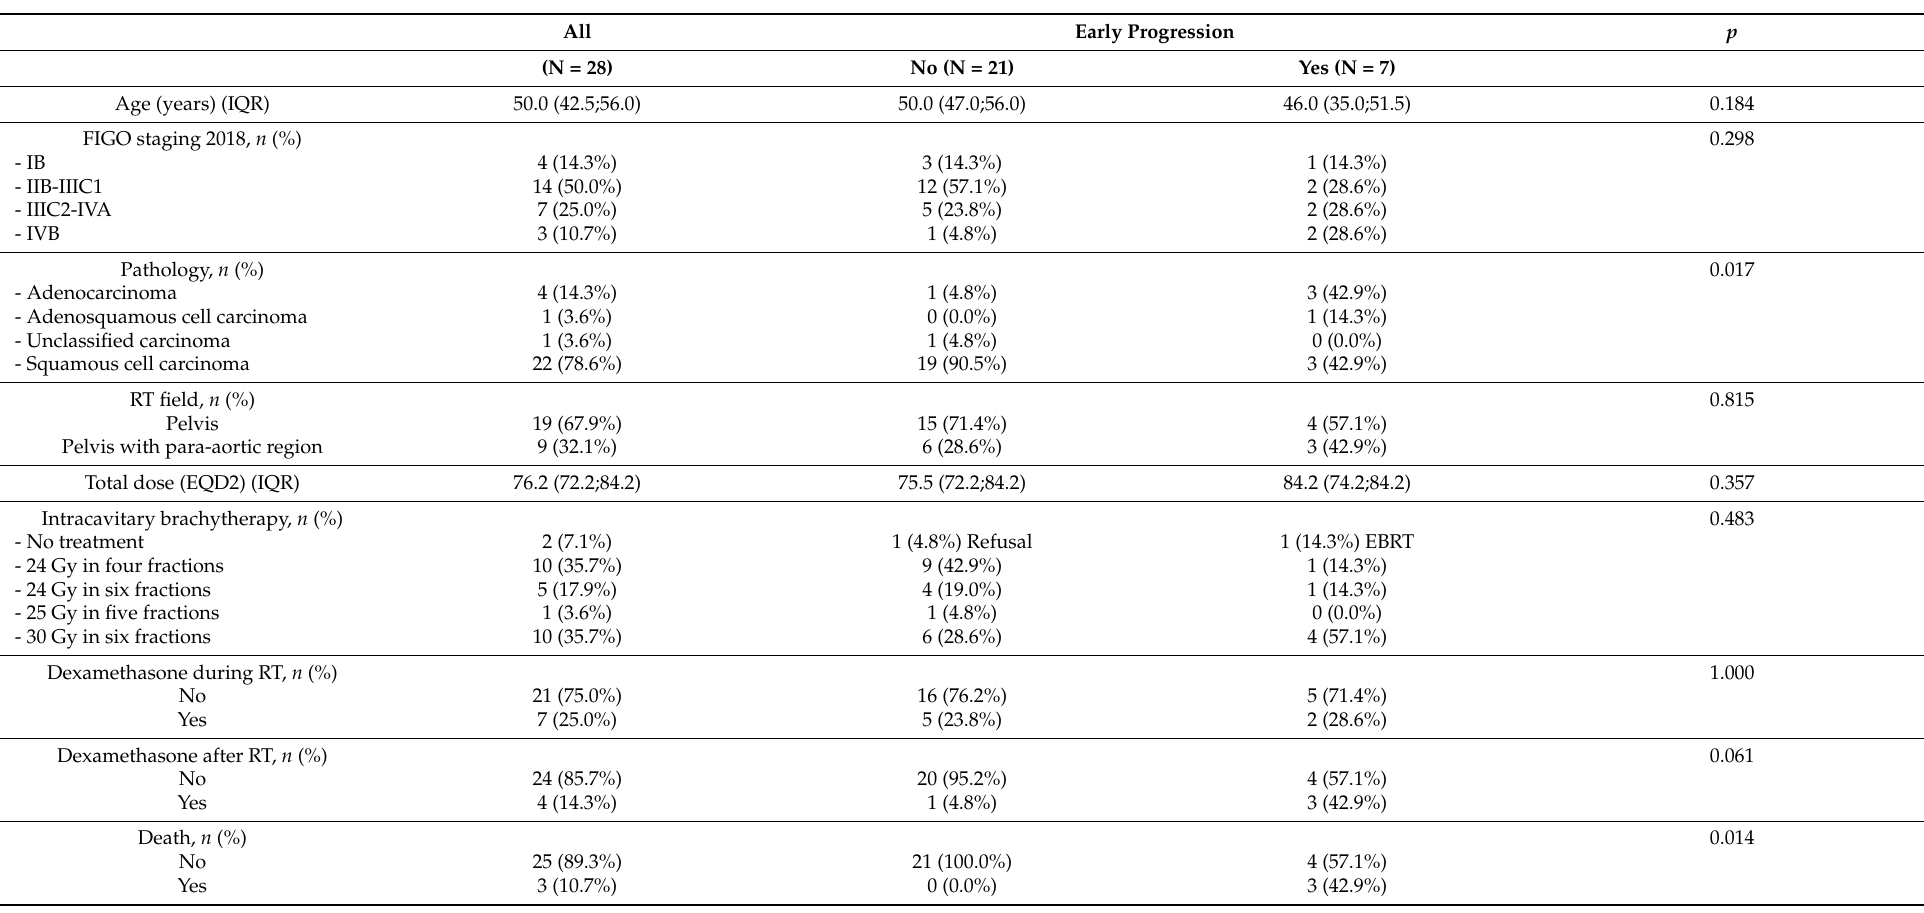
Table 1. Clinical characteristics of the